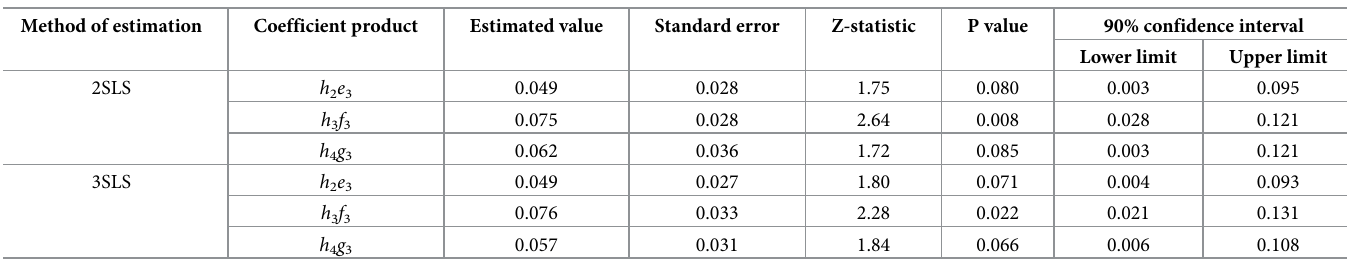
Table 11. Significance test of moderated mediation effects as robustness test.